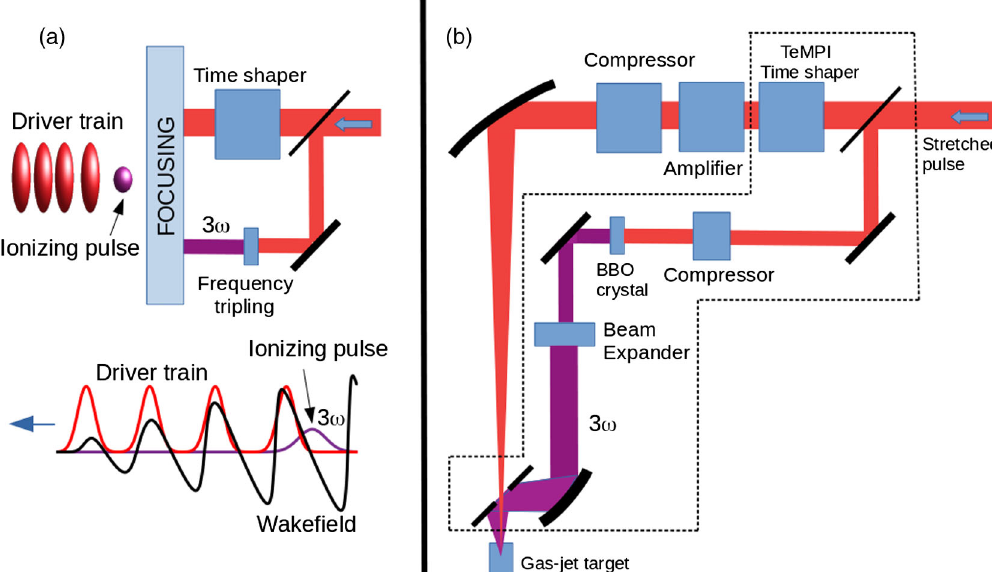
FIG. 1. The ReMPI setup. (a) Conceptual scheme: the incoming pulse passes through a beam-splitter; a portion (top line) is time shaped as a train of pulses, while a smaller portion is frequency tripled and tightly focused in the rear of the train. The driver train (four pulses, red line) resonantly excites an high-amplitude plasma wave (black line) and the ionizing pulse (perpendicular polarization, purple) is approximately placed in the node of the wakefield. (b) Experimental setup: the stretched pulse passes through a beam-splitter. The most energetic portion is time shaped through the passage into a TeMPI time-splitter (see text), further amplified and re-compressed by the grating compressor. The diver train is finally focused on the target (a gas-jet, gas-cell or a capillary delivering a mixture of H/He and a dopant (N, Ar), thus exciting a large-amplitude plasma wave. The low-energy portion of the initial pulse is amplified, frequency tripled through the passage into a thin nonlinear BBO crystal, temporally recompressed and radially magnified by using a reflective- beam expander. The 3 ω ionizing pulse is finally tightly focused with a short parabola and made collinear with the driver train by using an holed mirror. The region inside the dashed lines constitutes the experimental apparatus needed in addition to a standard LWFA